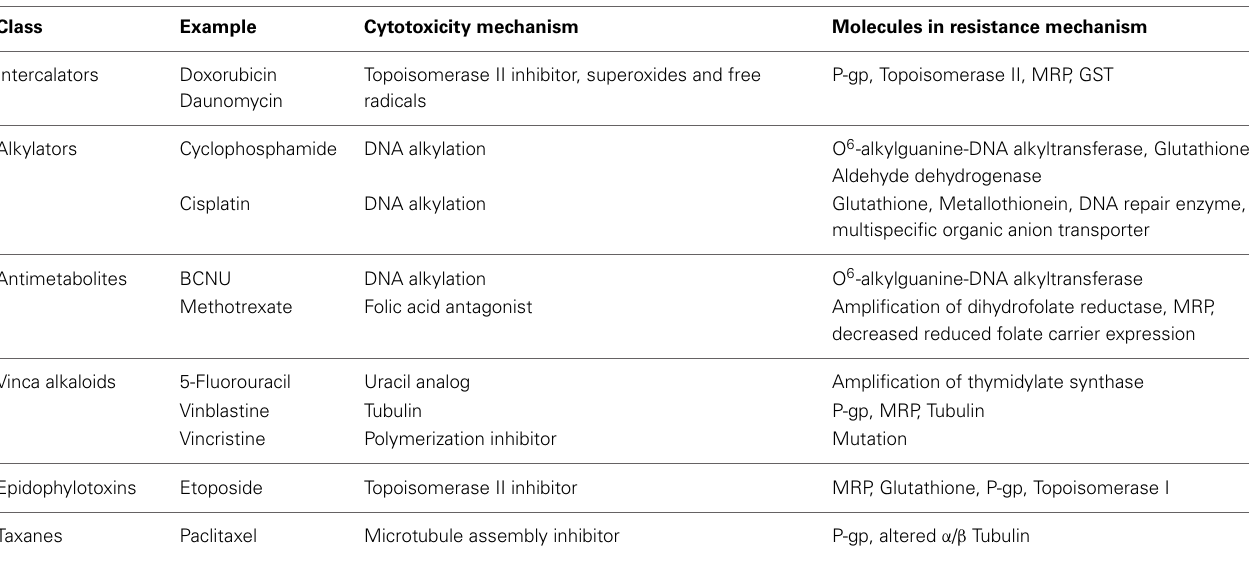
Table 1 | Drug resistance mechanisms of anticancer